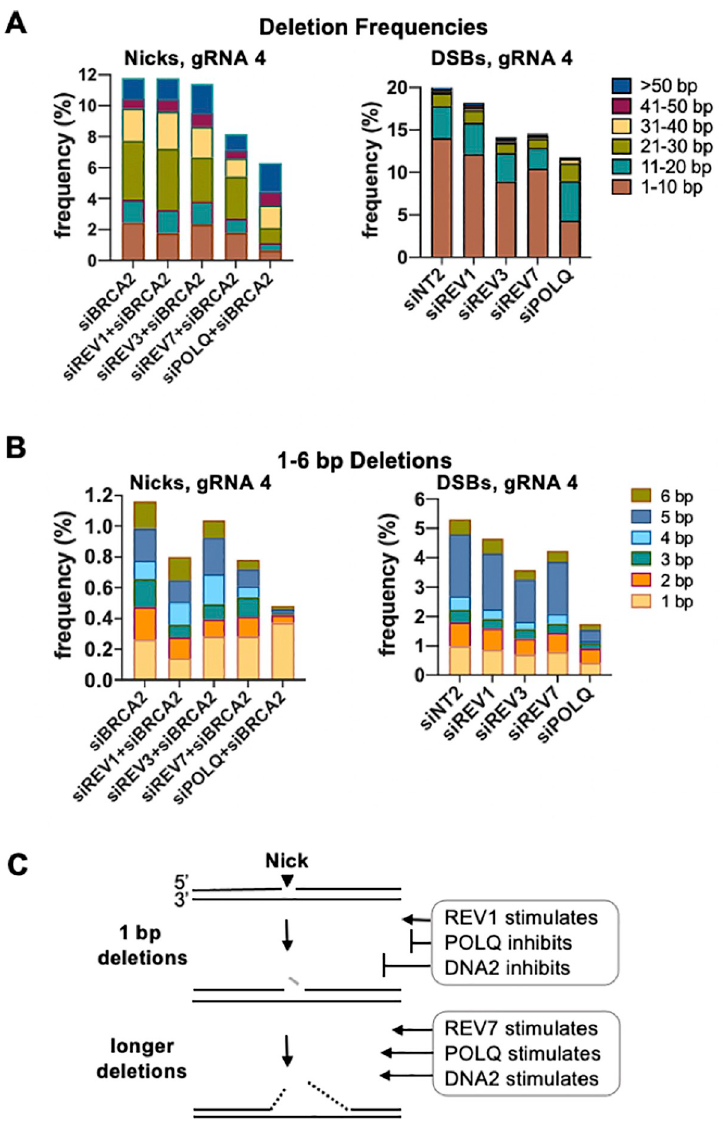
Fig 5. REV7 and POLQ promote deletions at nicks. (A) Effects of depletion of indicated factors on frequencies of deletions, binned by tens, at nicks and DSBs targeted by gRNA 4 to the CD44 gene of U2Os cells. (B) Effects of depletion of indicated factors on frequencies of 1–6 bp deletions. (C) Diagram of distinct regulation of 1 bp and longer deletions by REV1, REV7, POLQ and DNA2. Stimulation and inhibition indicated by lines, with relative lengths reflecting relative magnitudes of stimulation or